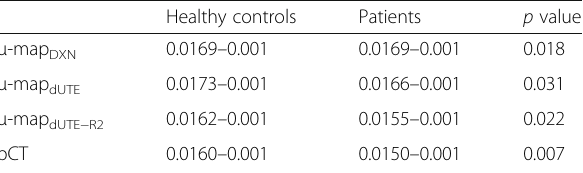
Table 7 Mean K i cer , standard deviation (min − 1 ), and p value between healthy controls and patients Healthy controls